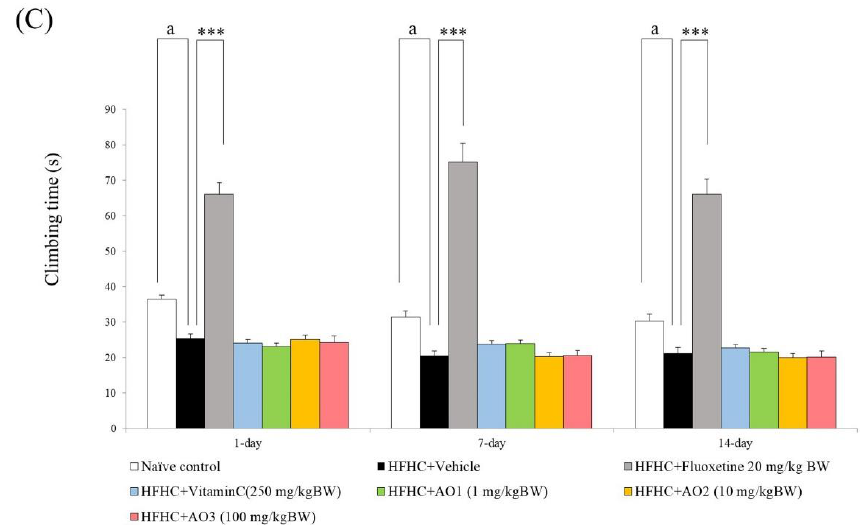
Figure 3. Antidepression-like activity of the functional ingredient containing cashew leaf extract and cashew pomace-derived dietary fiber (AO) evaluated by using forced swimming test. ( A ) Immobility time. ( B ) Swimming time. ( C ) Climbing time. Data are presented as mean ± SEM ( n = 6/group). a , aa p -value < 0.05 and 0.01 respectively, compared to naïve control that received ND and vehicle. *** p -value < 0.001 all; compared to metabolic syndrome rats induced by HFHC and received vehicle.